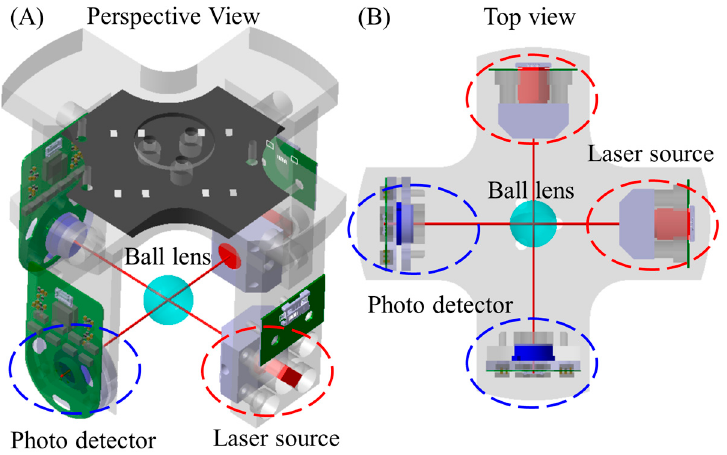
Figure 14. The sketch of the Laser R-test key components: ( A ) perspective view of the Laser R-test and ( B ) top view of the Laser R-test.